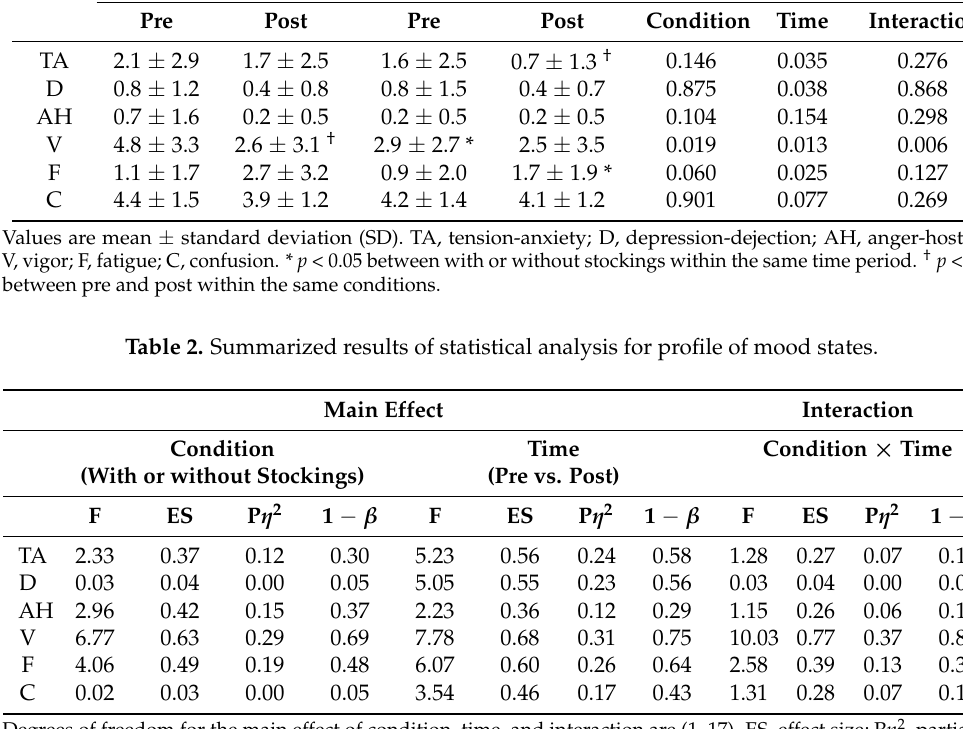
Table 1. Changes in Profile of Mood States scores across with or without compression stockings. Without Stockings With Stockings p -Value